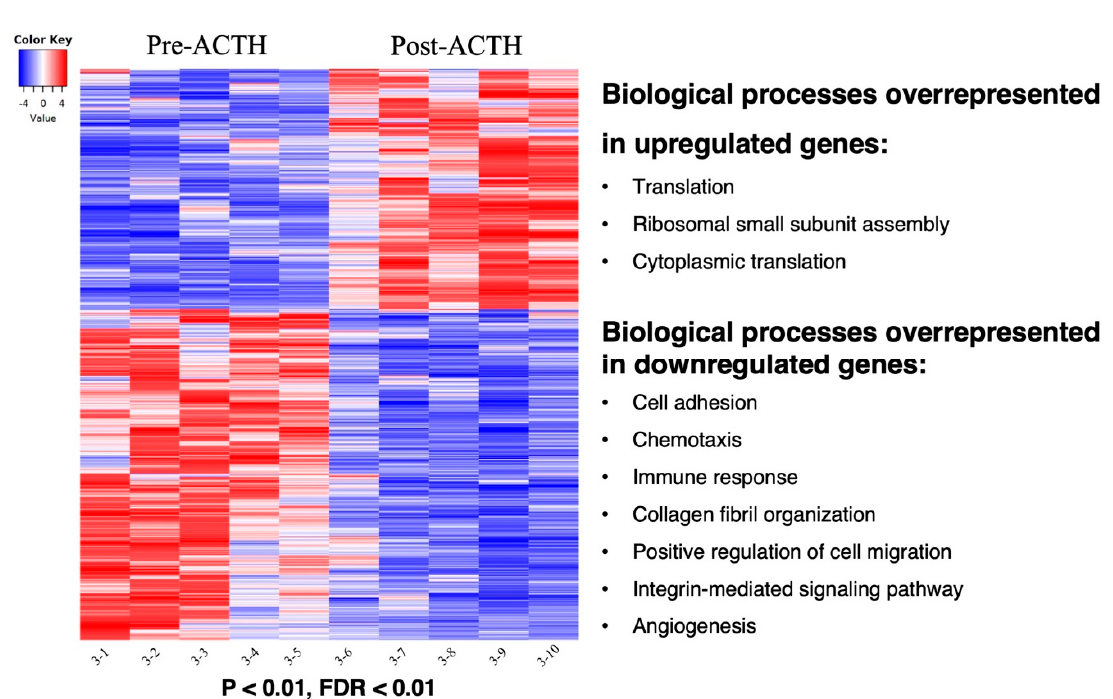
Figure 2. Heatmap of the 1190 differentially expressed genes (DEGs) in response to ACTH treatment and related functional terms analysis. Gradient of expression of each gene relative to its average expression is represented by colors red (high) to blue (low). 499 genes were upregulated in visceral adipose tissue (VAT) of animals after ACTH treatment whereas 691 genes were downregulated in samples before ACTH treatment ( p < 0.01, FDR < 0.01). Main significant overrepresented gene ontologies (biological processes) identified with DAVID analysis in each group of genes are presented. The entire list of DEGs and details of functional terms can be found in Supplemental Files S1 and S2, respectively.